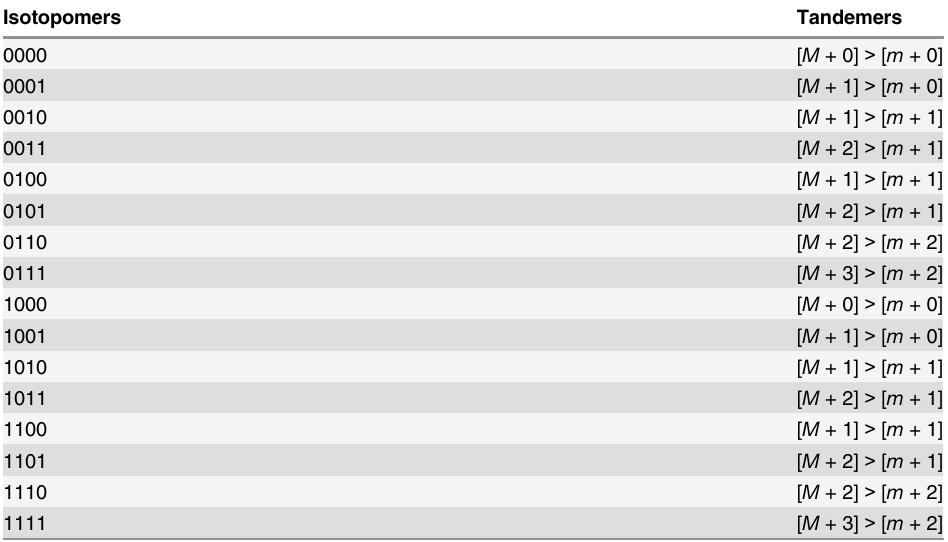
Table 1. The distribution of isotopomers of metabolite A (shown in Fig 2) within tandemers of A, defined with respect to A 2 ; 3 ; 4 f